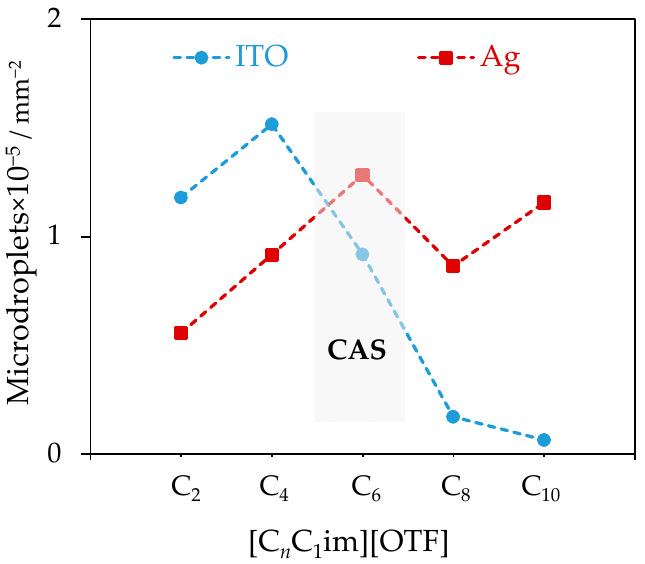
Figure 5. Schematic representation of the number of ionic liquid microdroplets (diameter greater than 1 µm) formed per mm 2 of surface area (ITO—blue circles, Ag—red squares) as a function of each ionic liquid in the [C n C 1 im][OTF] series.